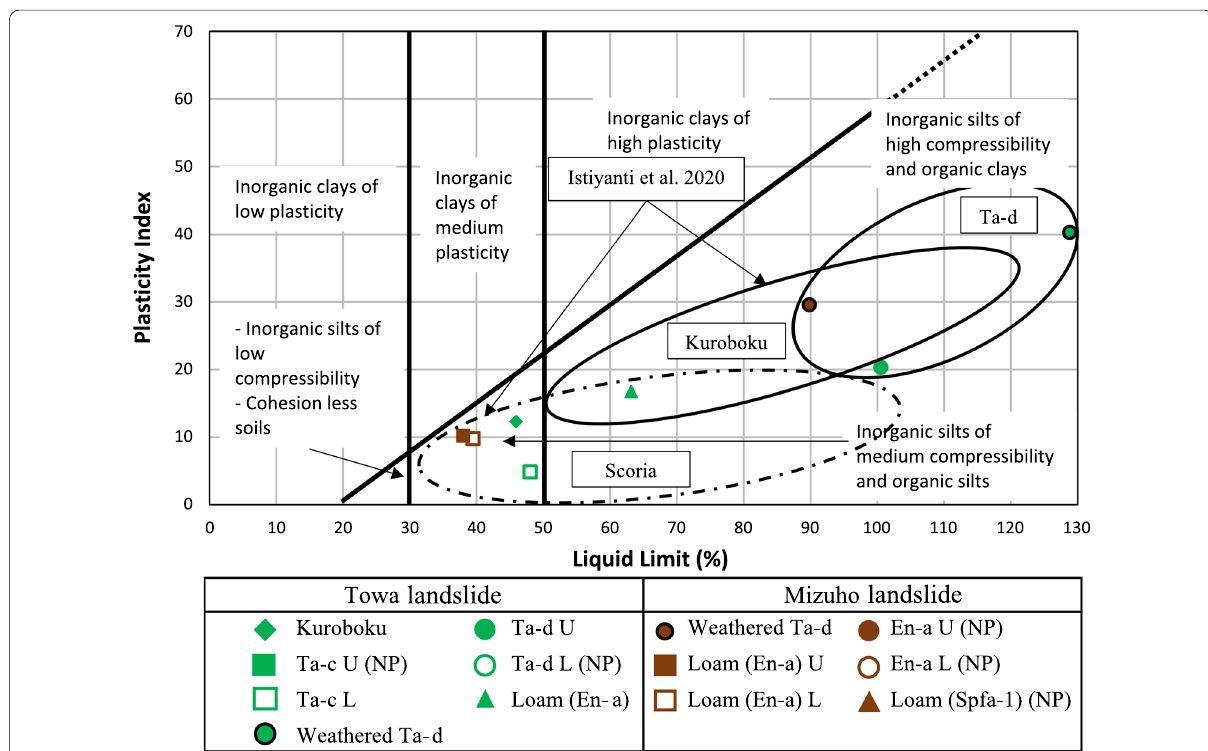
Fig. 7 Ellipse pattern from plotted data of tephra materials in Aso volcanic mountains (Istiyanti et al. 2020) and plotted data of tephra materials from Hokkaido on plasticity